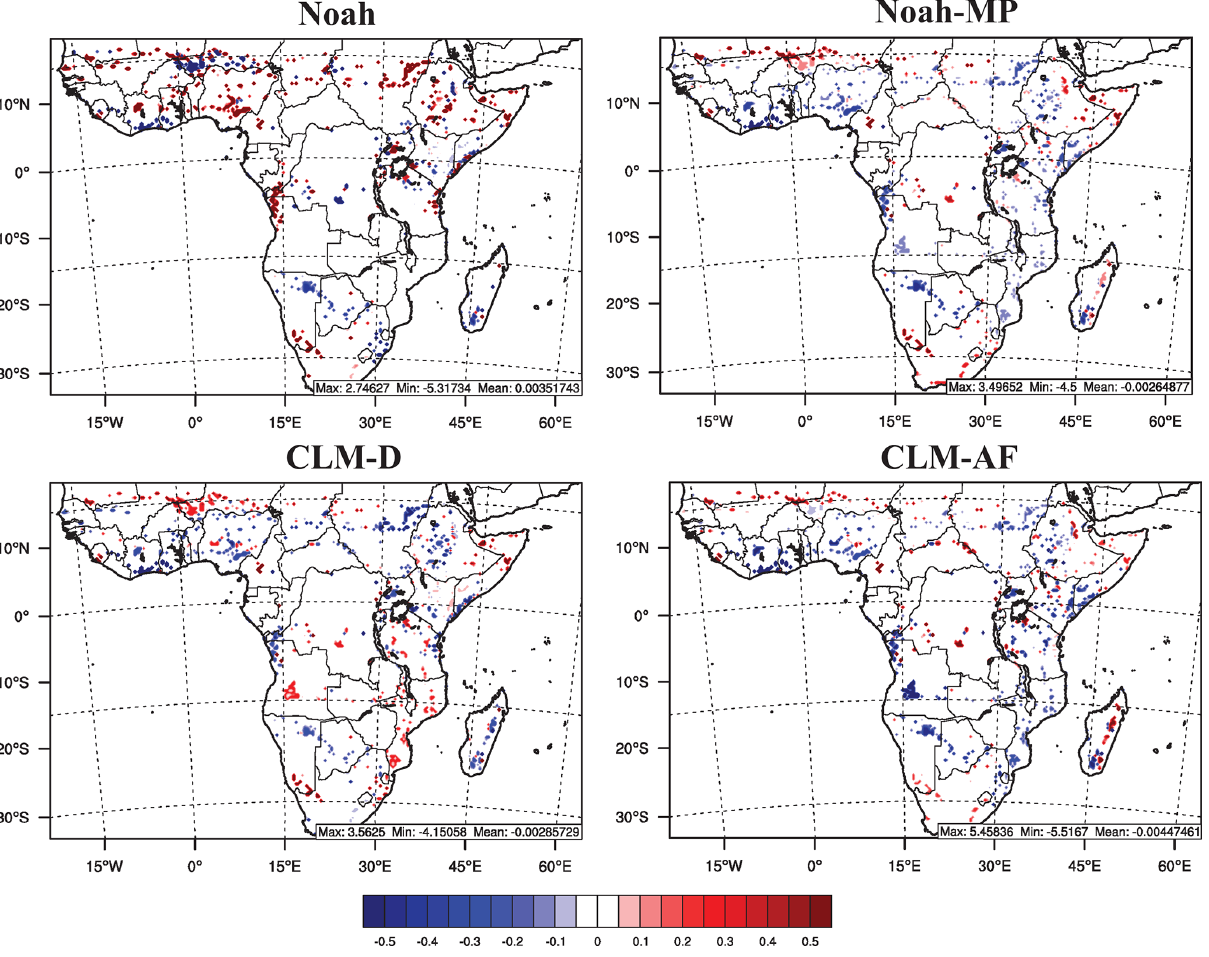
Figure 14. Differences in leaf area index (m 2 m − 2 ) between the LUD and LU01 (LUD-LU01) simulations using Noah, Noah-MP, CLM-D, and